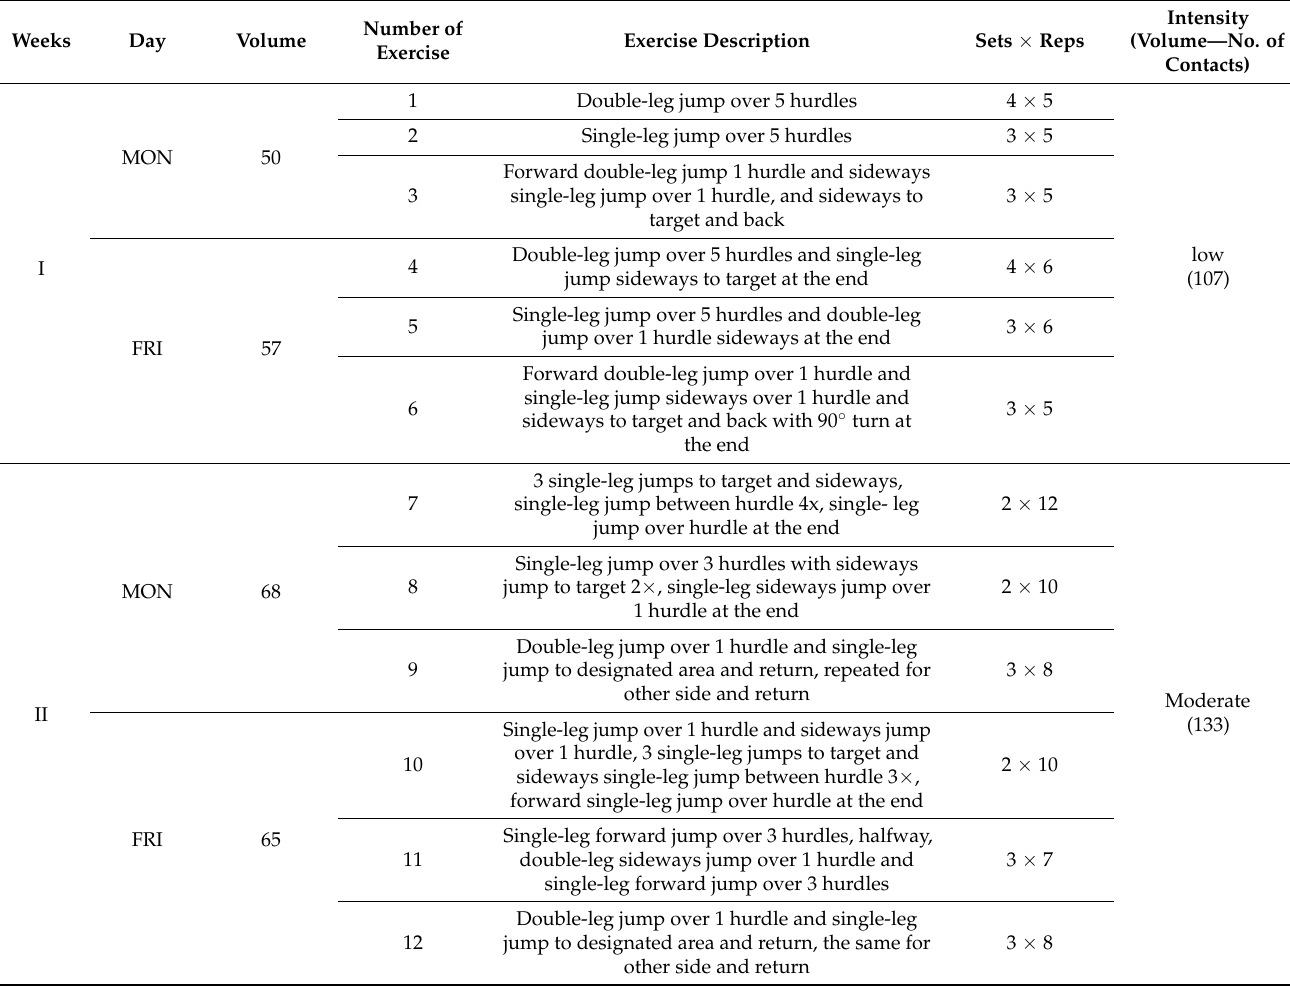
Table 1. Characteristics of the applied training